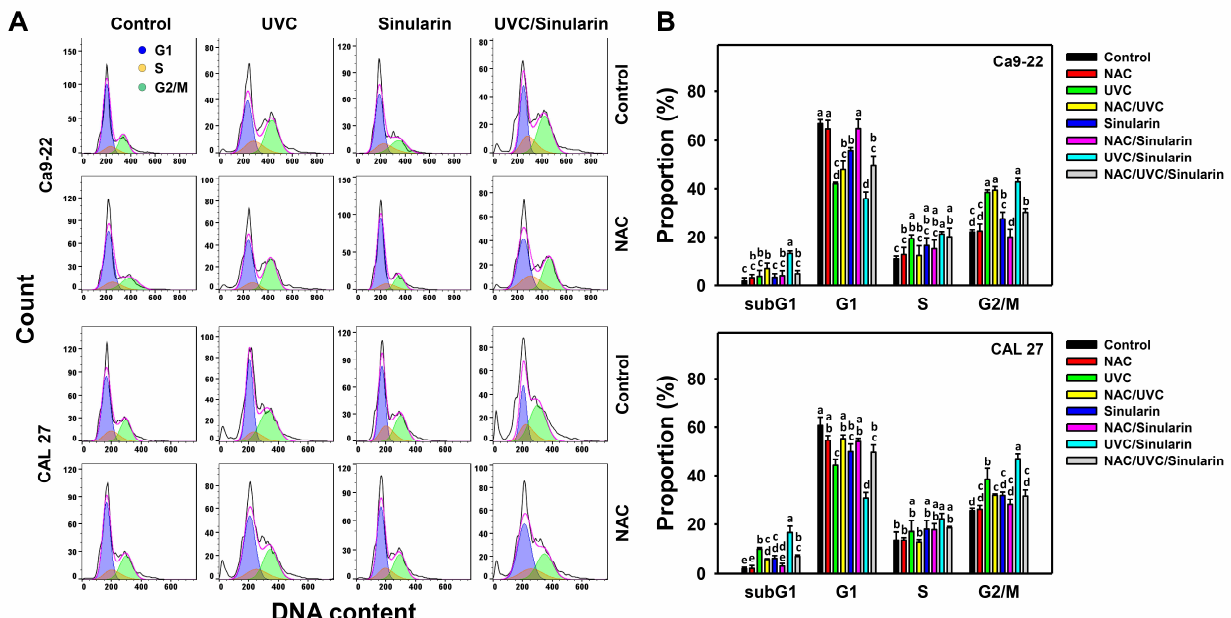
Figure 2. Cell cycle analysis for the UVC and/or sinularin treatments. Following the NAC preincubation (5 mM for 1 h) or not, the cells were arranged into four kinds of treatments: the control (0.1% DMSO in medium), UVC, sinularin, and UVC/sinularin for 48 h. The UVC and/or sinularin conditions were 12 J/m 2 , 2 μM and 10 J/m 2 , 3 μM for oral cancer cells (Ca9-22, CAL 27) for 48 h, respectively. ( A , B ) Patterns and quantifications for the cell cycle analysis. For multi-comparisons of the same cell cycle phase, the treatments marked without repeated characters (a to e) differ significantly ( p < 0.05). The data were plotted as the means ± SD ( n = 3).